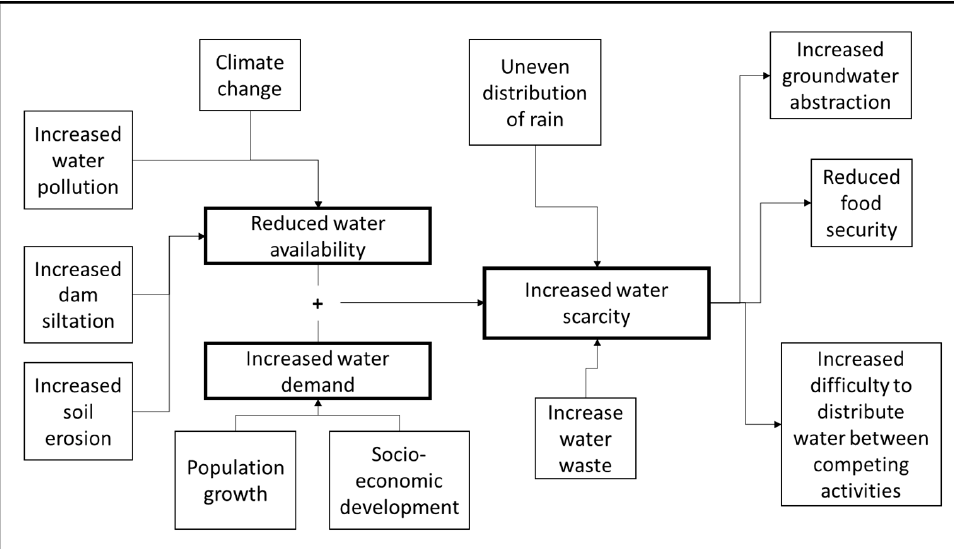
Figure 2. Policy problems and their interconnection. Source: the authors, based on policy documents specified in Appendix A.